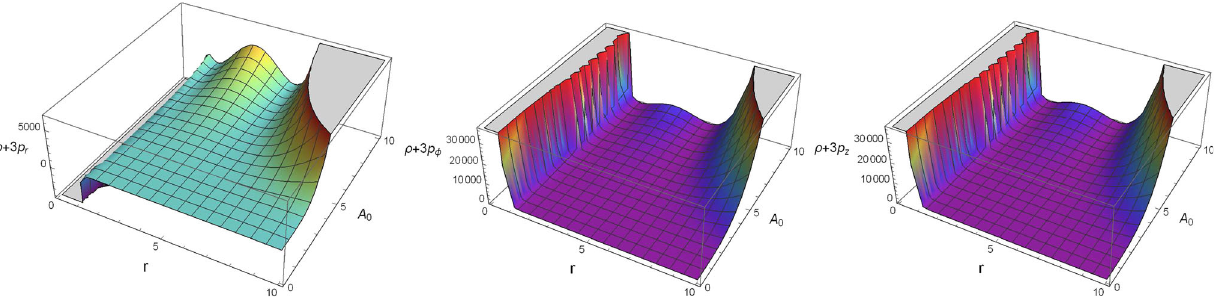
Fig. 11 The graphical variation in this panel shows the behavior of (ρ + 3 p r ) (MeV/fm 3 ) , (ρ + 3 p φ ) (MeV/fm 3 ) and (ρ + 3 p z ) (MeV/fm 3 ) w.r.t r (km) and A 0 parameter with m = n = 1 and α = − 0 . 01. CASE